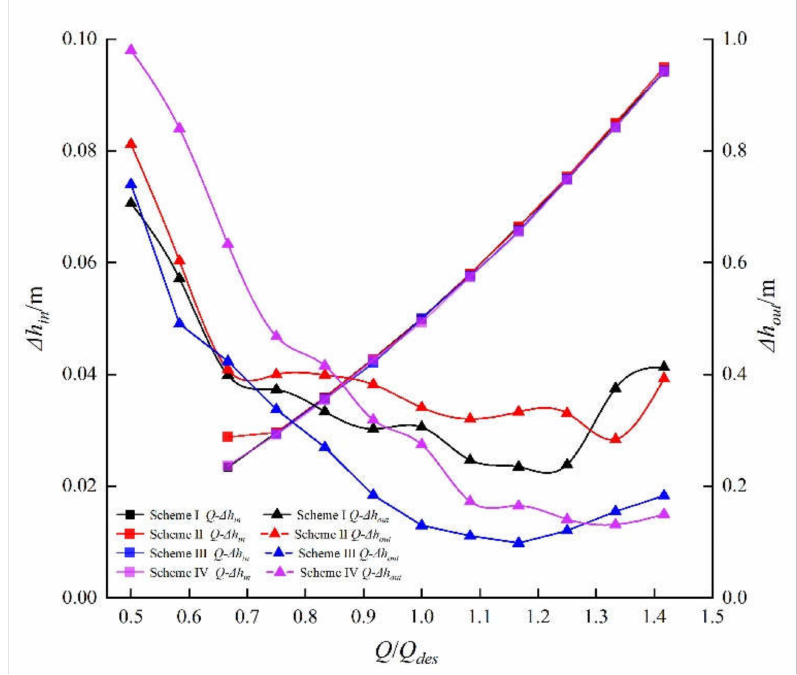
Figure 18. Hydraulic loss curves of outlet channel in different